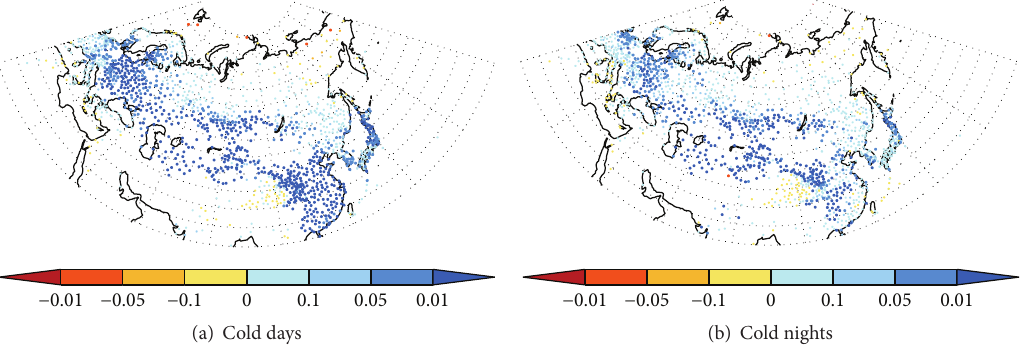
Figure 4: Statistical significance of correlation coefficients between the ECI and the occurrence of station cold days (a) and cold nights (b). Here, we also used the 10th percentile threshold but substituted a stationary climatology for 1973–1992 following Zhang et al. [27]. The values of the colored bars represent the significance of the two-tailed Student’s 𝑡 -test at each station (dot); the positive (negative) sign denotes a positive (negative)